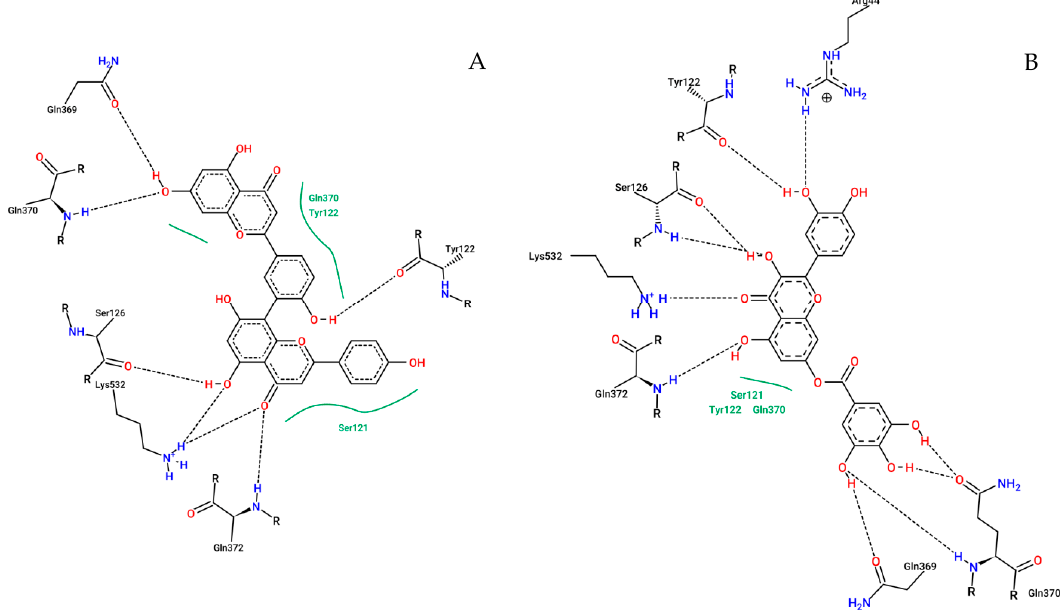
Figure 12. 2D representation of the interactions of COX-2 residues with amentoflavone ( A ) and quercetin- O -gallate ( B ). Dashed lines represent hydrogen bonds; green lines represent van der Waals interactions.